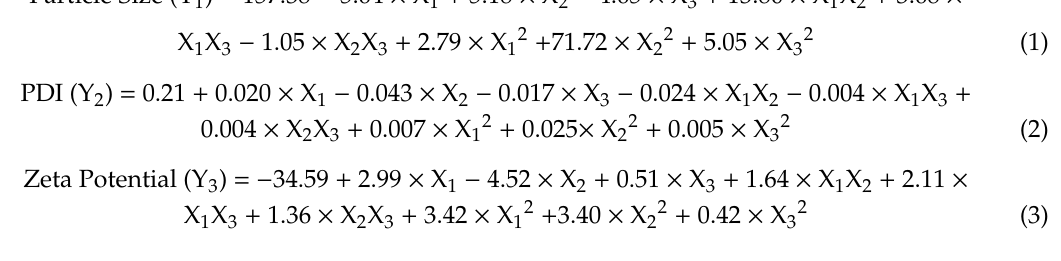
Table S2. After multiple linear regression analysis of the data, the following polynomial equations describing the quantitative e ff ect of studied independent factors and their interactions on the responses were